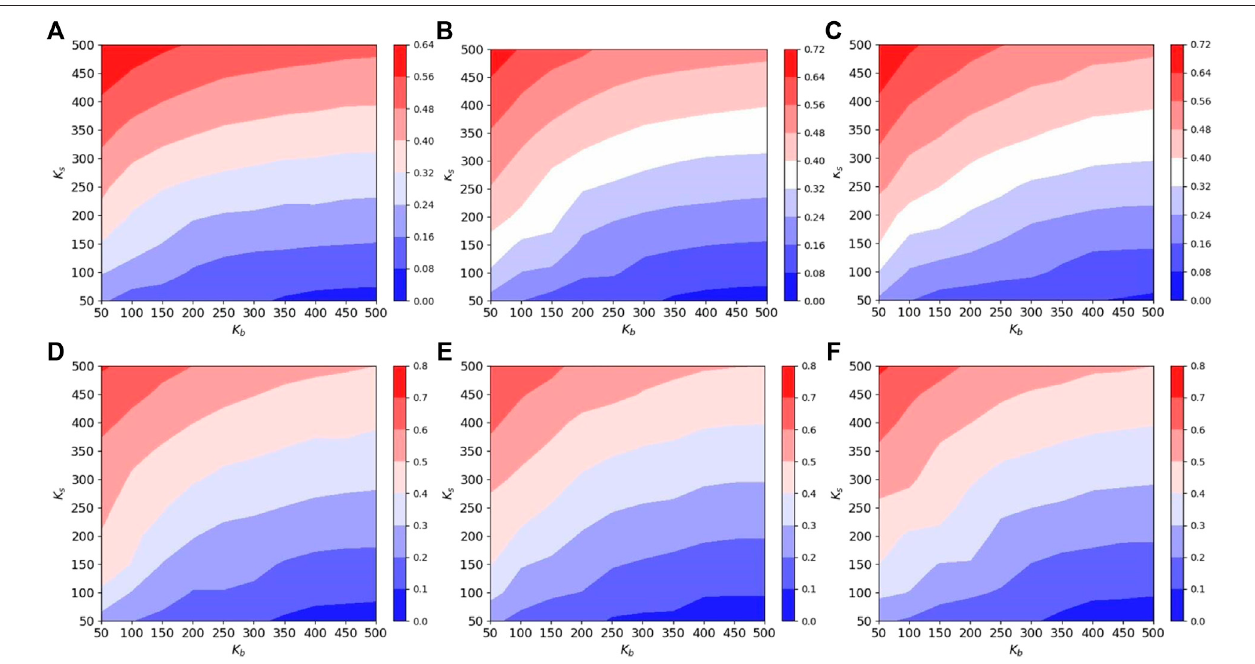
FIGURE 5 | Contour plots of equilibrium utility values with the number of blocker ’ s and spreader ’ s seed nodes K b , K s on degree heterogeneous networks with different power exponents. (A) Power exponent γ = 2.0; (B) power exponent γ = 2.1; (C) power exponent γ = 2.2; (D) power exponent γ = 2.3; (E) power exponent γ = 2.4; (F) power exponent γ =